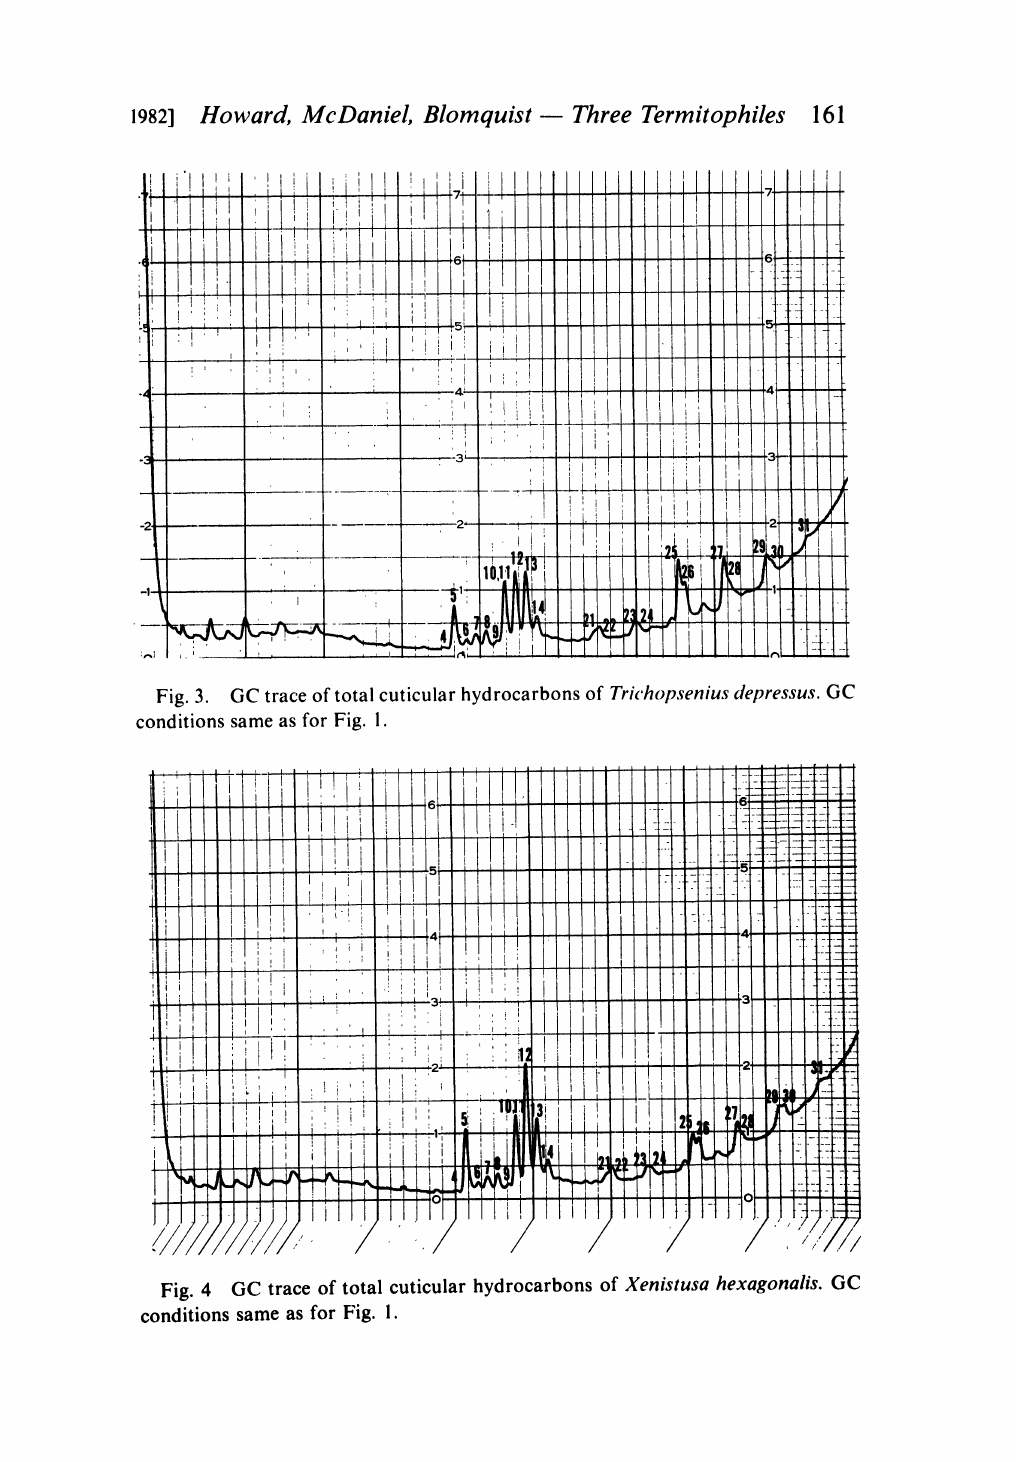
Fig. 4 GC trace of total cuticular hydrocarbons of Xenistusa hexagonalis. GC conditions same as for Fig.